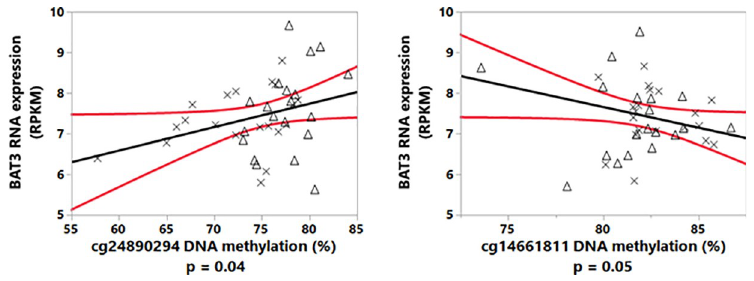
Fig 6. Linear model of cg24890294 and cg14661811 DNA methylation-dependent mRNA expression of BAT3 . Crosses represent the data points of children with asthma and the triangles represent those children without asthma (r 2 = 0.15 for the linear model).